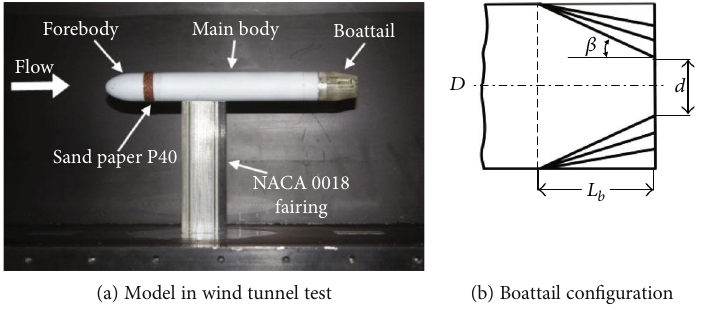
Figure 1: Schematic picture of the experimental set-up. Table 1: Geometrical parameters of the boattails tested in this study. Angle β ( ° ) d /